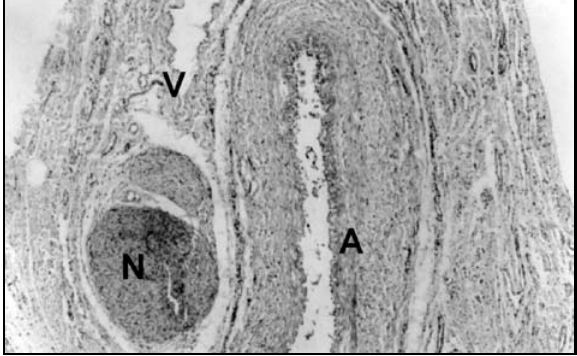
Figura 3 – Microscopia (HE 60x) do pedículo do seqüestro pulmonar do caso 1 N: filetes nervosos; A: artéria de médio calibre; V: